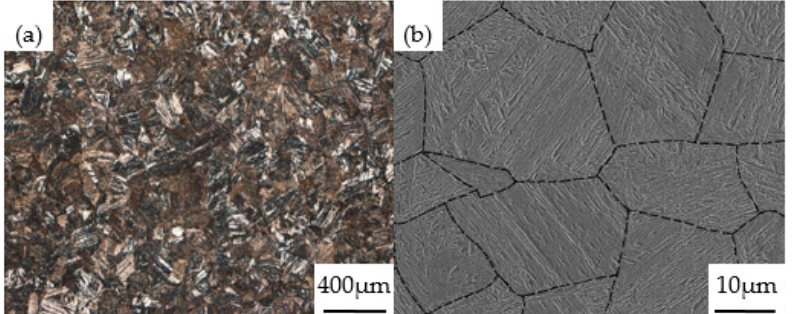
Figure 3. Optical microscopy (OM) image ( a ) and scanning electron microscopy (SEM) image ( b ) showing the microstructures of the as-quenched martensite in the experimental steel.